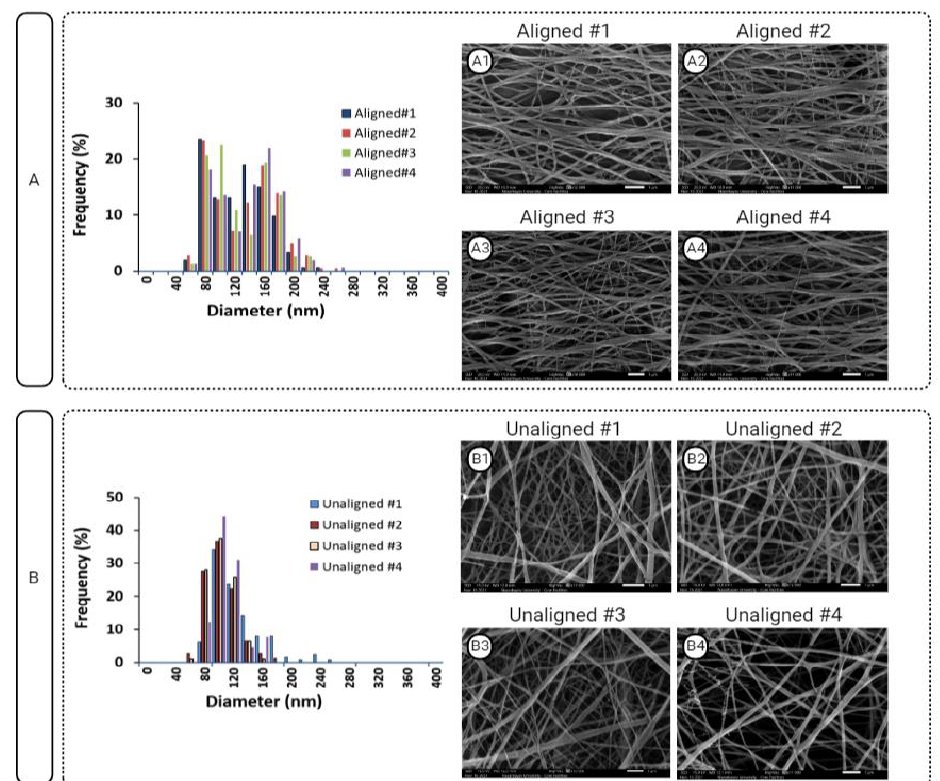
Figure 4. Distribution of fiber diameters of ( A ) aligned and ( B ) unaligned PCL constructs together with their corresponding (A1–4 and B1–4) SEM images. Scale bar = 1 µ m. Polymers 2023 , 15 , x FOR PEER REVIEW